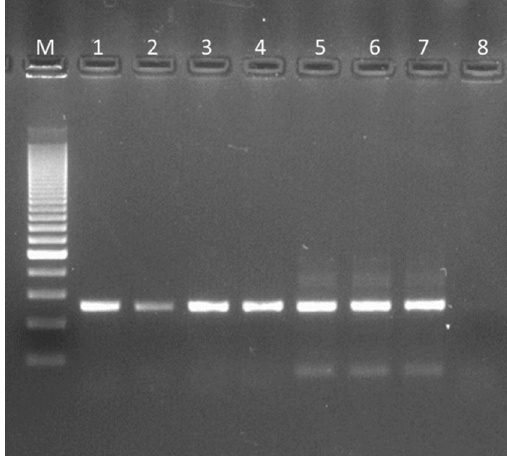
Figure 1. Specific PCR assay for L. crispatus 16S rRNA; positive results obtained from vital colonies grown on plates. Within the figure: Marker 200 bp (M); LMG 9479- L. crispatus type strain (1); Product A (2); Product B (3); Product D (4); Product E, MD (5); Product F (6); Product I, MD (7); negative template control (8).